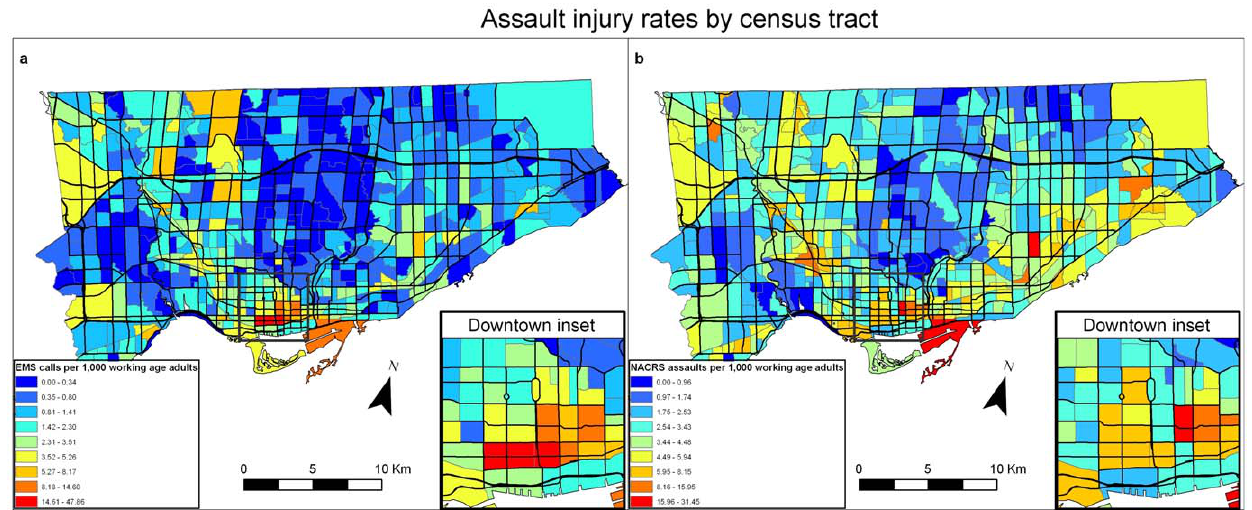
Figure 6. Choropleth maps of rates of assault in injury by census tract (2001 Canadian Census). Figure 6a: Rates of injury for assaults for EMS database by census tract. Figure 6b: Rates of injury for assaults for NACRS database by census tract.